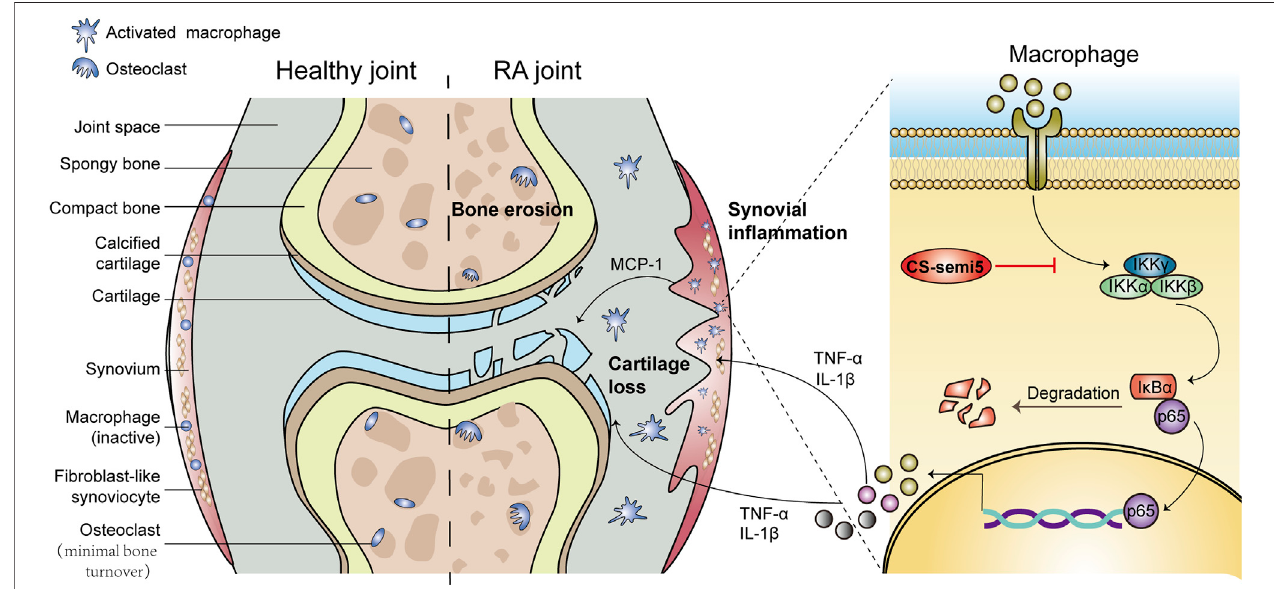
FIGURE 8 | Schematic diagram summarizing the mechanisms by which CS-semi5 alleviates synovial in fl ammation, cartilage erosion and bone loss in RA. CS- semi5 effectively inhibits the NF- κ B signaling pathway, including p65 nuclear translocation and phosphorylation of p -IKK α / β and p-NF- κ B, both in vivo and in vitro . CS- semi5 also reduces TNF- α and IL-1 β production by activated macrophages and blocks RANKL-trigged osteoclast differentiation of macrophages.